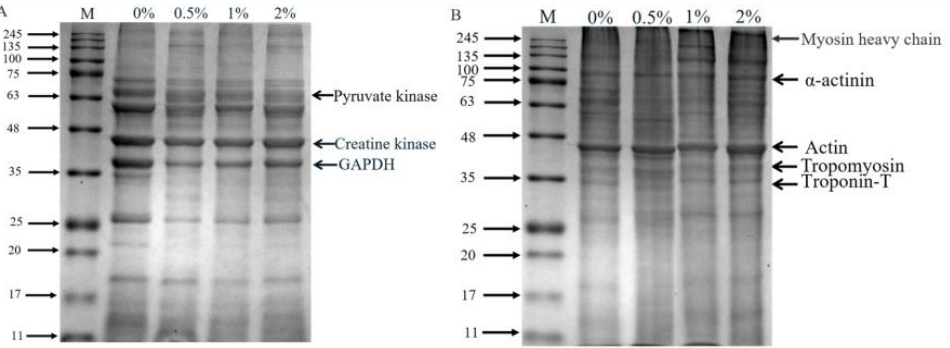
Figure 3. SDS-PAGE profile of sarcoplasmic ( A ) and myofibrillar proteins ( B ). Specifically, 0%, 0.5%, 1% and 2% represent potassium lactate levels. The proteins in gel were identified according to the molecular weight of standard proteins (11–245 kDa) and previous studies [4,33]. In the sarcoplasmic proteins, 63 (pyruvate kinase), 43 (creatine kinase) and 37 (GAPDH); in the myofibrillar proteins, 220 kDa (myosin heavy chain), 100 kDa ( α -actinin), 43 kDa (actin), 36 kDa (tropomyosin) and 33 kDa